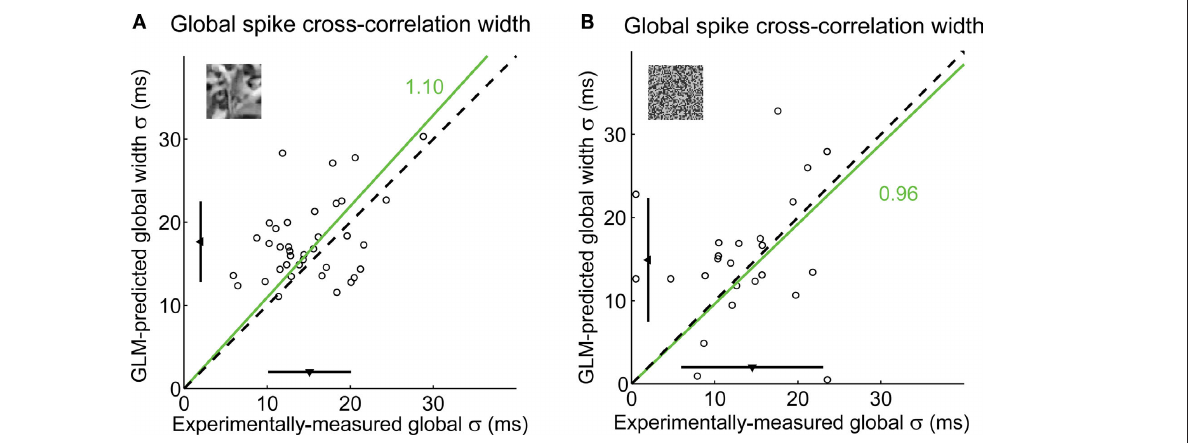
by the GLM and that measured experimentally using a least-mean-square fit on all data points. The mean ± standard deviation are represented along each axis by an arrowhead and bar. The dashed line has unity slope. (B) Global spike cross-correlation width in response to spatiotemporal white noise, as predicted by the GLM versus measured in experimental data, in all pairs in which there was a measurable hump in the cross-correlation for this class of visual stimuli ( n = 24 pairs). Same conventions as in (A)